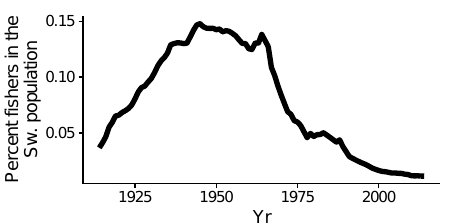
Fig A1.1. Percent fishers in the Swedish population. Note that the fishing has never been a major Swedish industry (the fisher population never exceeded 0.15 %) but has decreased further since the 1960s. In 2014, the Swedish population was 9.7 million and the number of fishers were 1100, which yields the fraction fisher of the total population 0.01